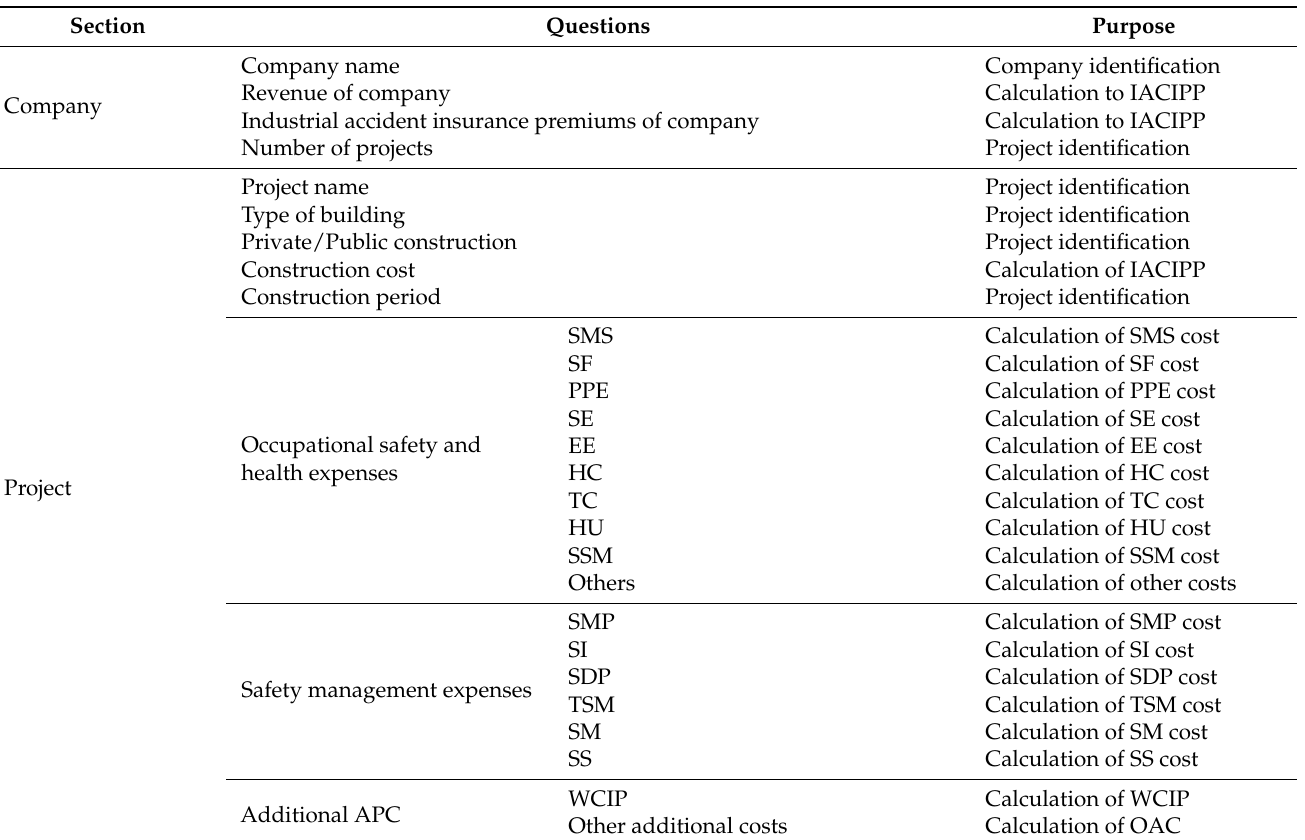
Table 6. Questions for survey based on the proposed